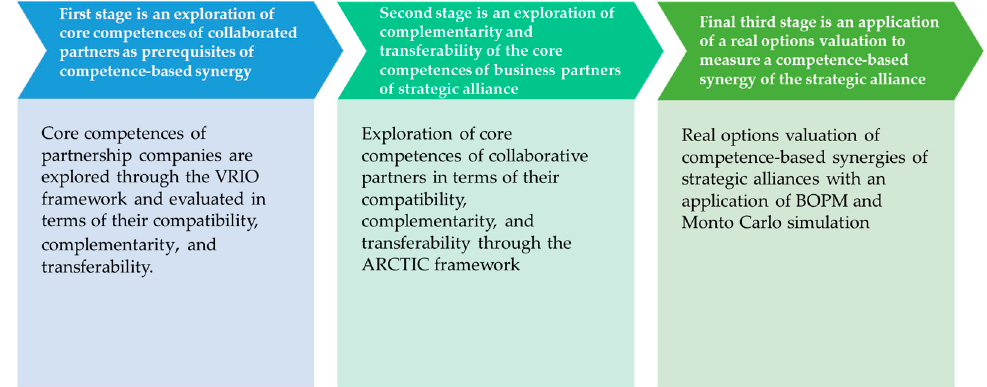
Figure 3. A recommended research framework for future research.